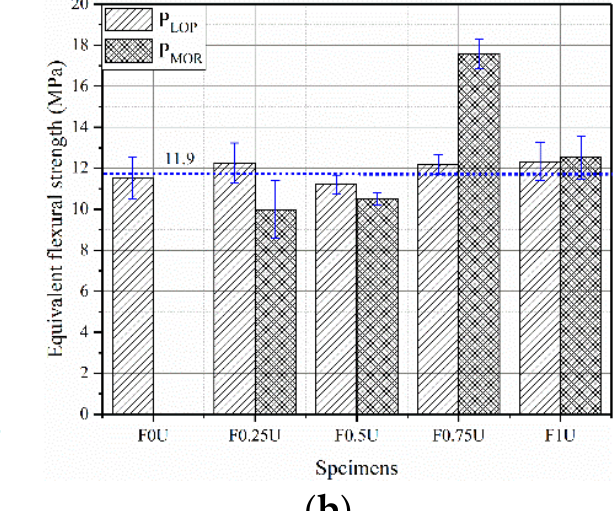
( b ) Figure 5. Load – deflection curves ( a ) and equivalent flexural strength ( b ) of specimens. The initial crack strength of F0U and F0.25U is greater than that of the flexural strength (P LOP > P MOR ), which is a deflection softening behavior. The flexural strength at the initial crack strength of F0.75U, F1U is greater than that of the flexural strength (P LOP < P MOR ), which is a deflection hardening behavior. In other words, the bottom thickness is less than 50 mm for deflection softening behavior and more than 50 mm for deflection hardening behavior. This is due to the thin bottom fiber layer (<50 mm), which results in a weak bridging effect provided by the fibers. The flexural strength is mainly provided by